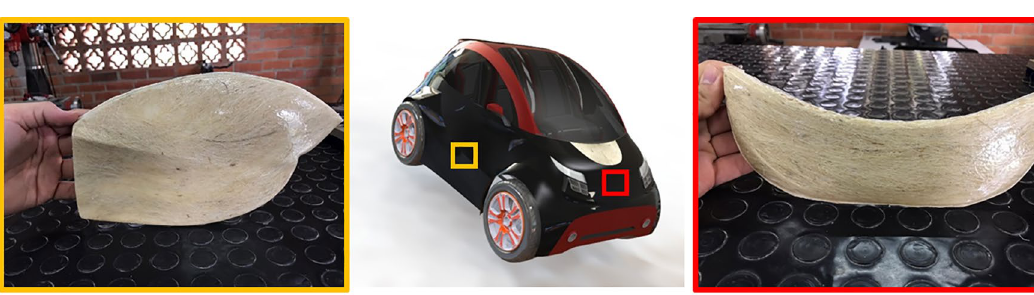
Figure 11. Automotive parts (door and hood) produced from EP-UF 0° biocomposites (scale